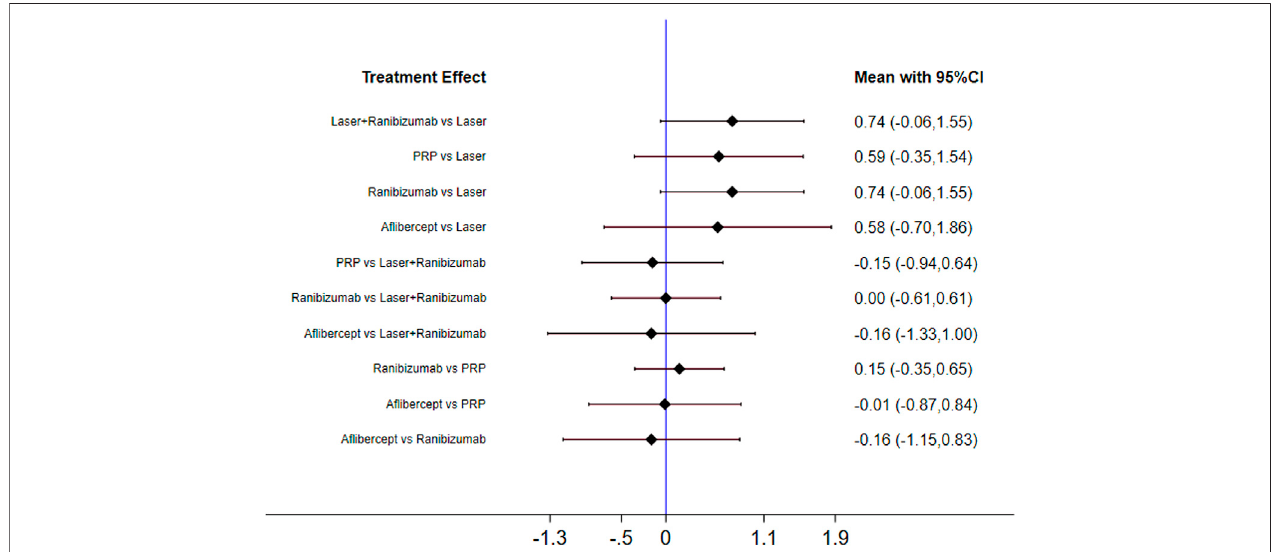
FIGURE 3 | Forest plots for head-to-head comparisons of SMD of vision score change. Horizontal lines indicate the range of 95% CI.